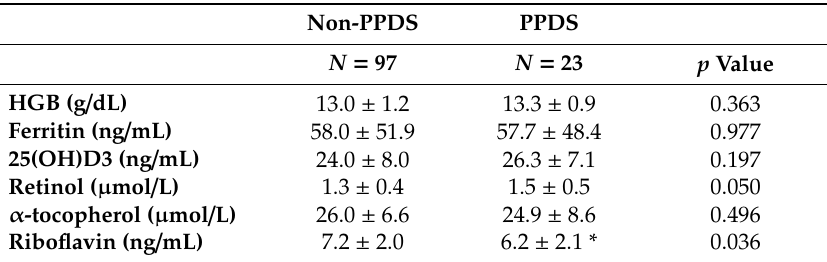
Table 2. Nutritional biomarkers of the postpartum women a .